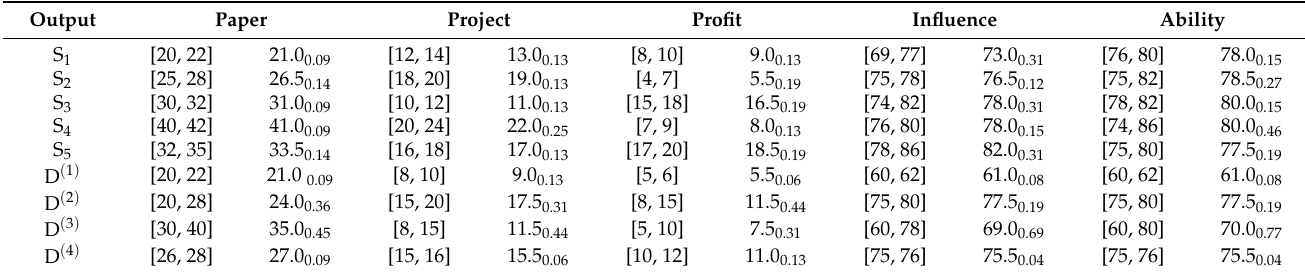
Table 2. Evaluation value and reference point value under output indicators.